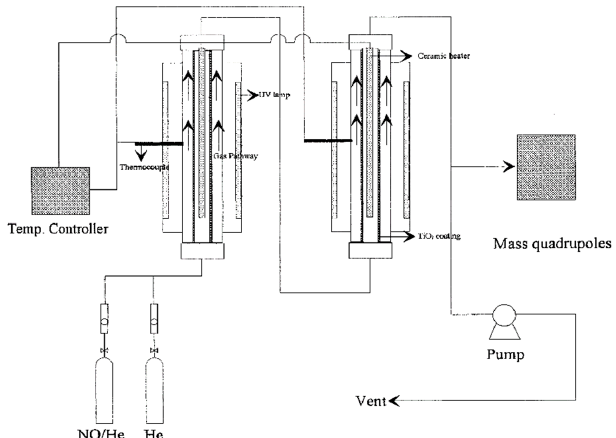
Figure 16. Schematic diagram of the annular flow-type photoreactor composed of two quartz glass tubes (height, 500 mm; diameters, 12 mm and 20 mm). Reproduced with permission from Lim and